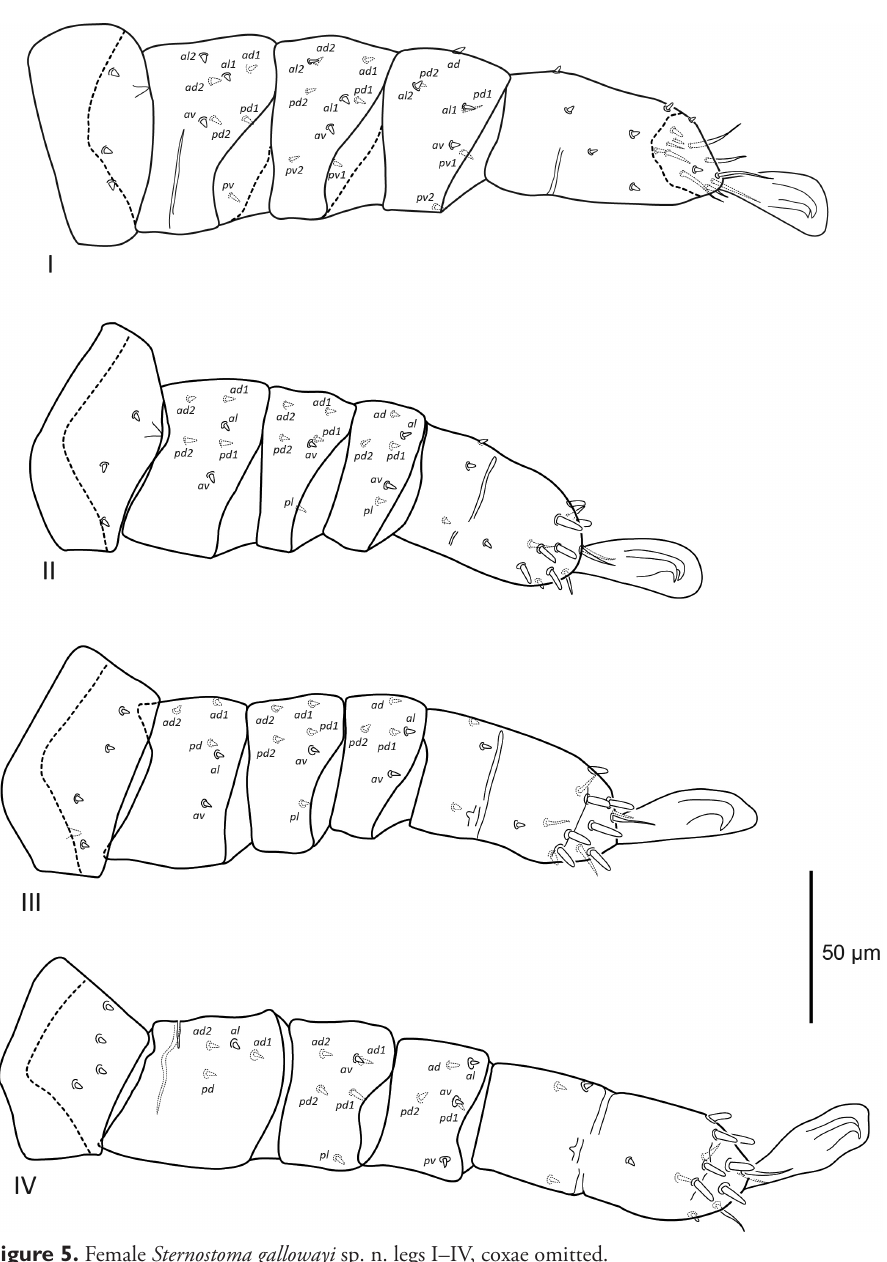
Figure 5. Female Sternostoma gallowayi sp. n. legs I–IV, coxae omitted. of palps 0–3–3–2–5, all setae with rounded tips, palp apotele absent. Chelicerae widest proximally and tapering distally, 60 (57–63) long and 19 (18–20) at widest point, with small pointed fixed and moveable